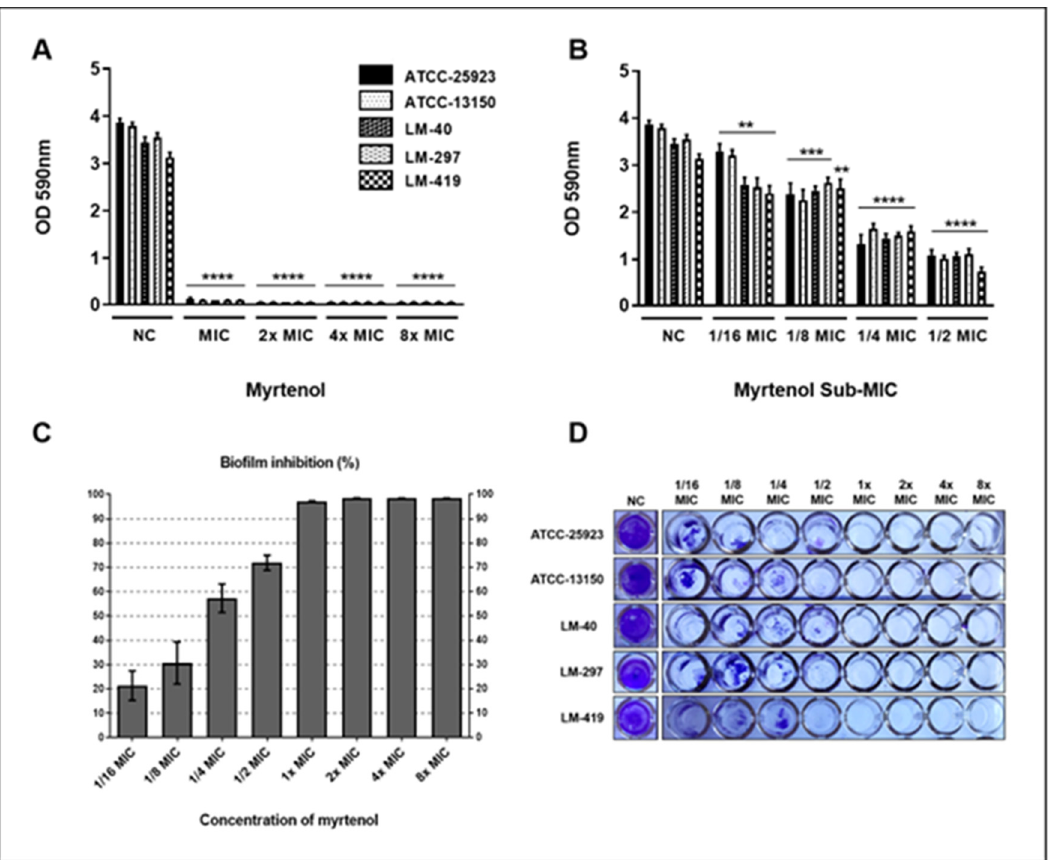
Figure 3. Myrtenol antibiofilm effect against Staphylococcus aureus . ( A ) Suprainhibitory concentrations; ( B ) Subinhibitory concentrations; ( C ) Percentage inhibition of biofilm formation; ( D ) View of biofilms formed in vitro by S. aureus in the presence and absence of myrtenol. NC: negative control. Statistical analysis compared to negative control: **** p ≤ 0.0001; *** p ≤ 0.001; ** p ≤ 0.01.